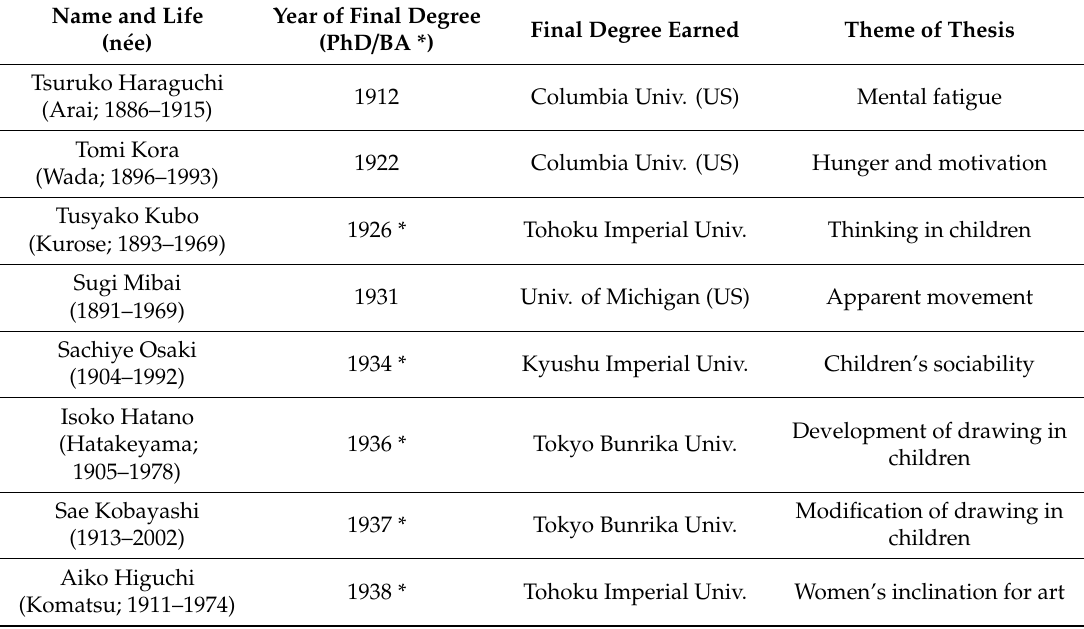
Table 2. Summary of the first generation of Japanese women